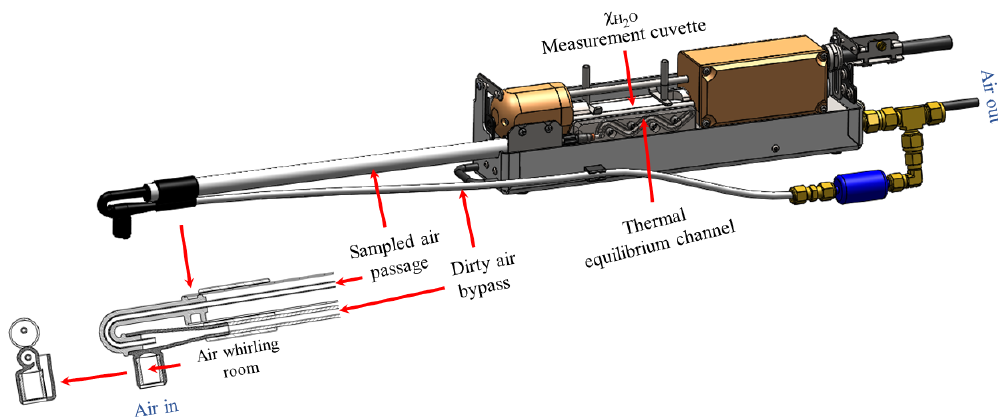
Figure 3. Vortex intake system for airflow through its individual compartments: air whirling room (2.200mL), sampled air passage (1.889mL), thermal equilibrium channel (0.587mL), and χ H measurement cuvette (5.887mL). The internal space of all compartments 2 O adds up to a total volume of